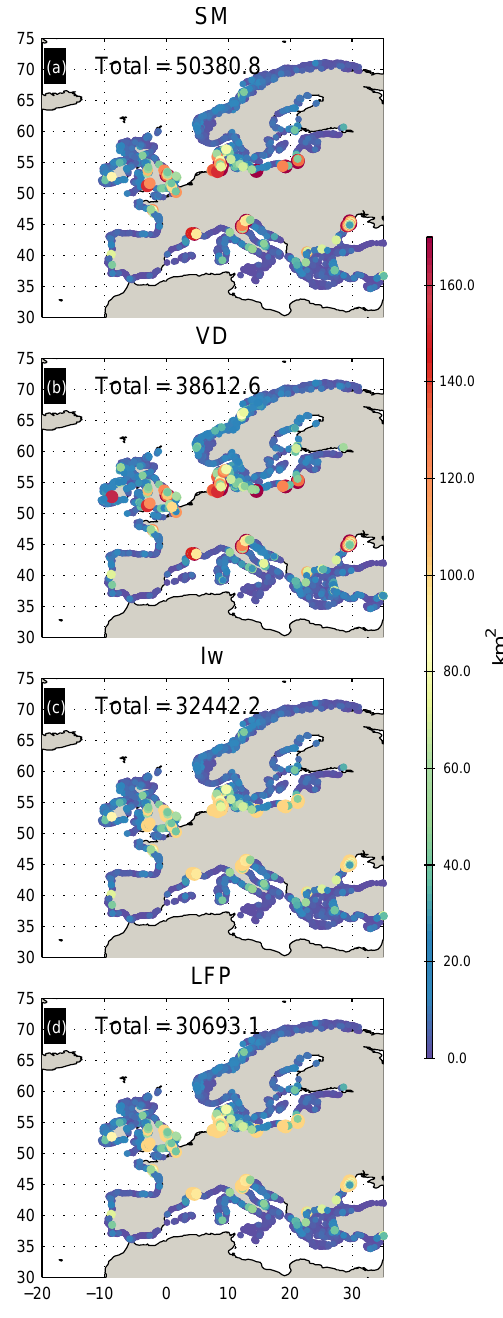
Figure 5. Estimated coastal flood extent for the present-day 100-year event using all four approaches. Values are shown for each 25km coastal segment and correspond to km 2